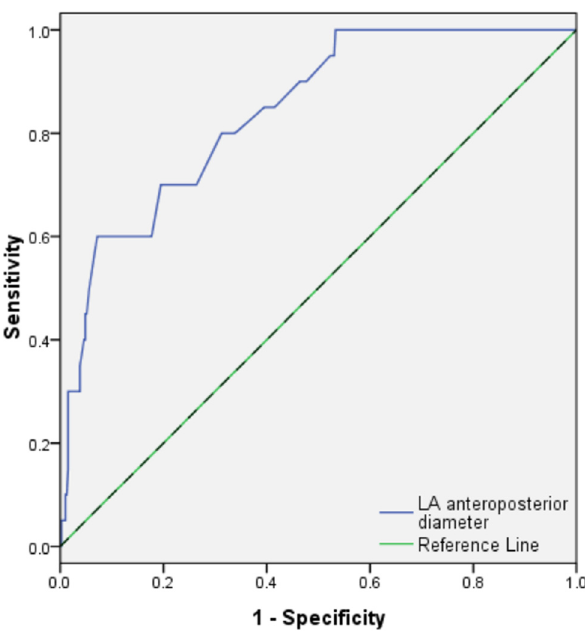
Figure 1: ROC analysis of LA anteroposterior diameter in predicting LAAT. LA = left atrium, LAAT = left atrial appendage thrombus.